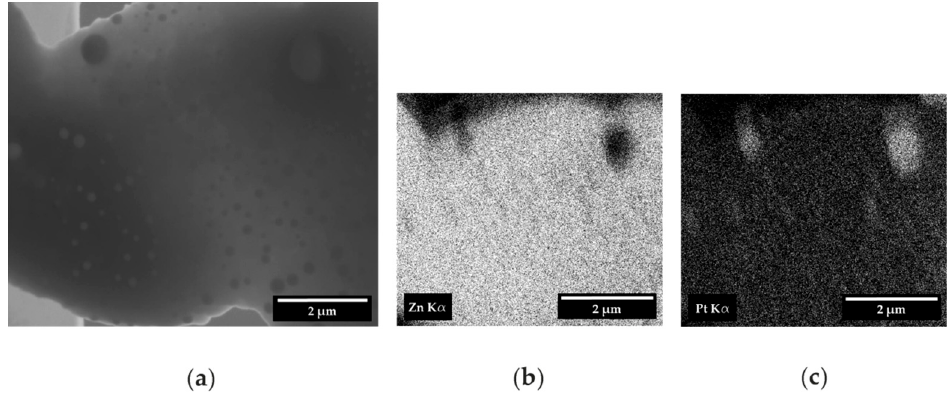
Figure 8. EDX map of ZnO green body after shrinkage at 400 °C with applied electric current. ( a ) SEM image, ( b ) Zn EDX signal, and ( c ) Pt EDX signal in sintered ZnO lamella.